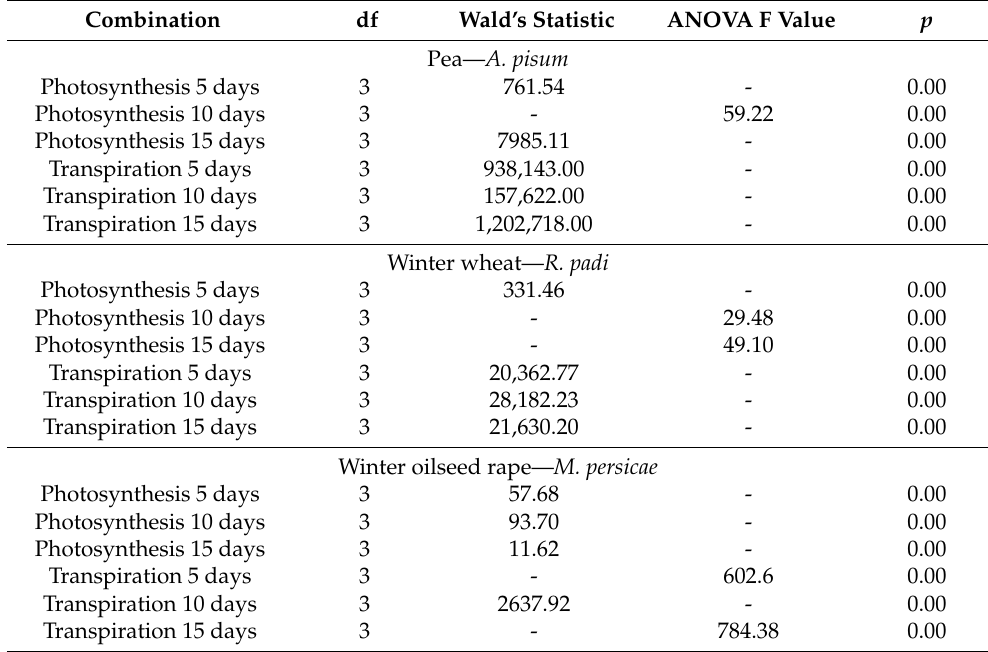
Table 2. Results of statistical tests (GLM, ANOVA) for the intensity of photosynthesis and transpira- tion in peas ( A. pisum ), winter wheat ( R. padi ) and winter oilseed rape ( M. persicae ). Combination